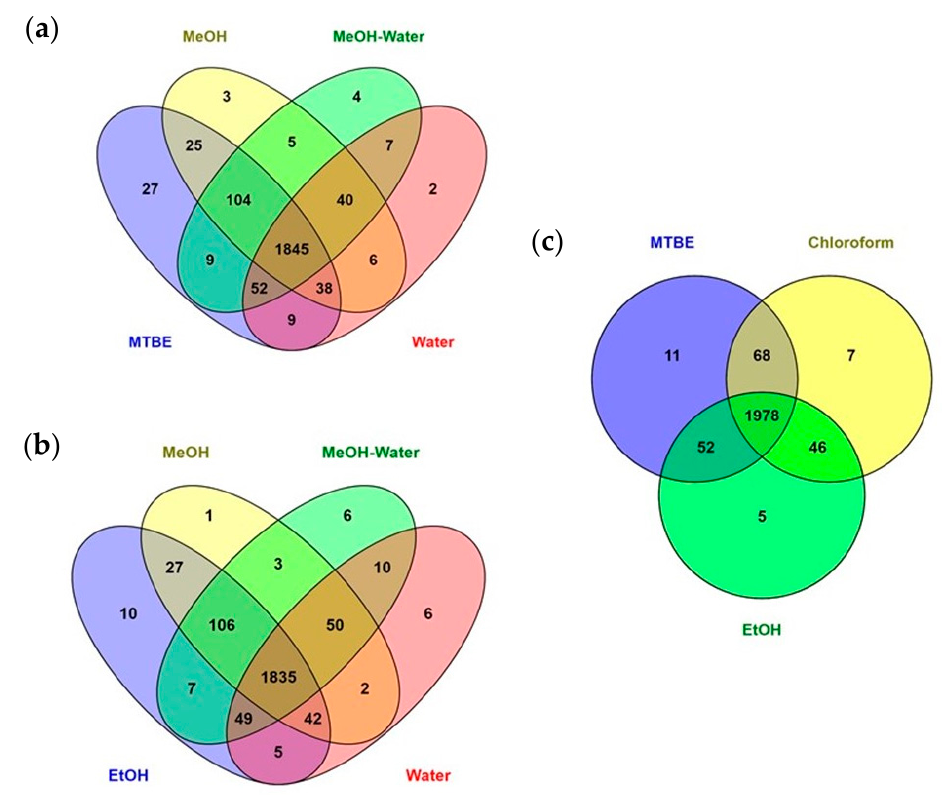
Figure 5. Comparison of the mean numbers of features (triplicate of each extraction protocol); ( a ) comparison of single-phase extractions; ( b ) comparison of MTBE with single-phase extractions; ( c ) comparison of ethanol (which gave the highest number of features among the single-phase extractions) with liquid–liquid extractions.